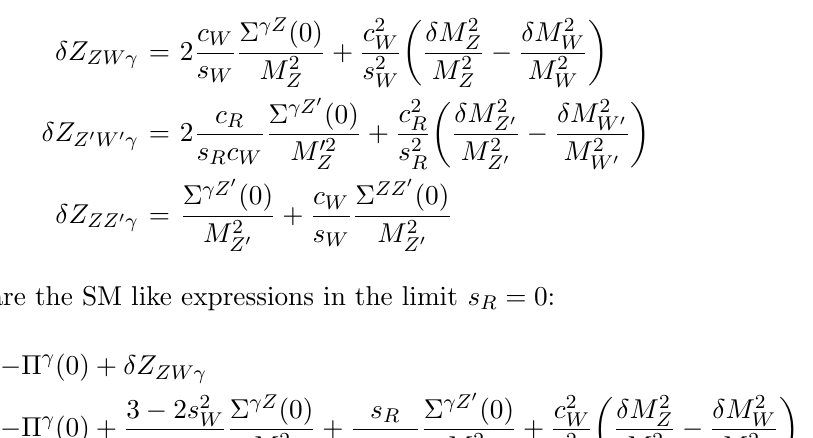
Figure 4 . Self-energy diagrams for the W and Z boson in Left-Right models involving scalars only. and one has